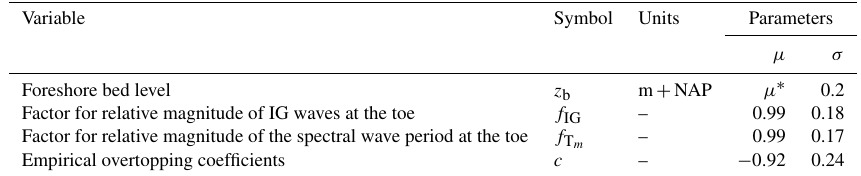
Table A2. Normally distributed foreshore parameters. Note that the mean value ( µ ∗ ) is dependent on location along the Wadden coast.